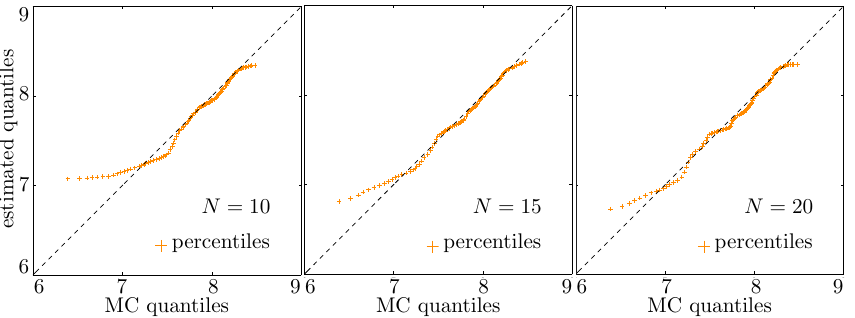
Fig. 7. Quantile-quantile plots, analogous to Fig. 4. On the x-axis there are the estimates of the quantiles of g given by a MC simulation with N = 10 3 , which are close to the true values.